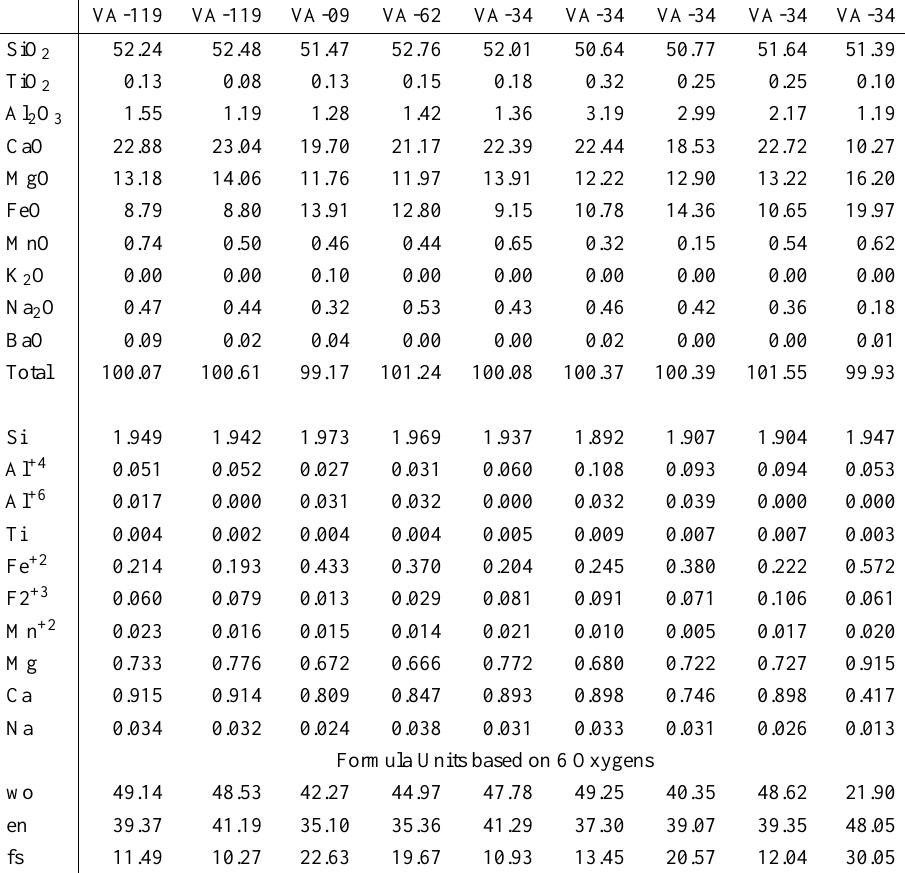
Representative Microprobe analyses of